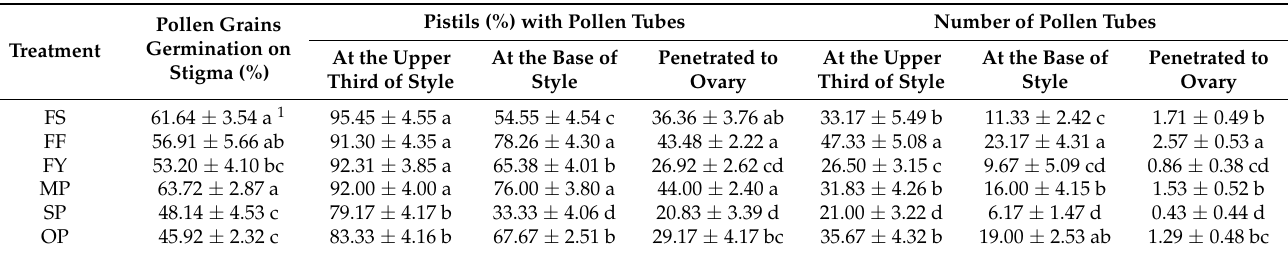
Figure 2. Fluorescence microscopic images of pollen germination and pollen tube growth of ‘Feng- tangli’ plum with various pollination treatments. Scale bars, 100 µm. Table 1. Pollen germination on the stigma surface, percentage of pistils with pollen tubes in different parts of the style and ovary, number of pollen tubes in style.